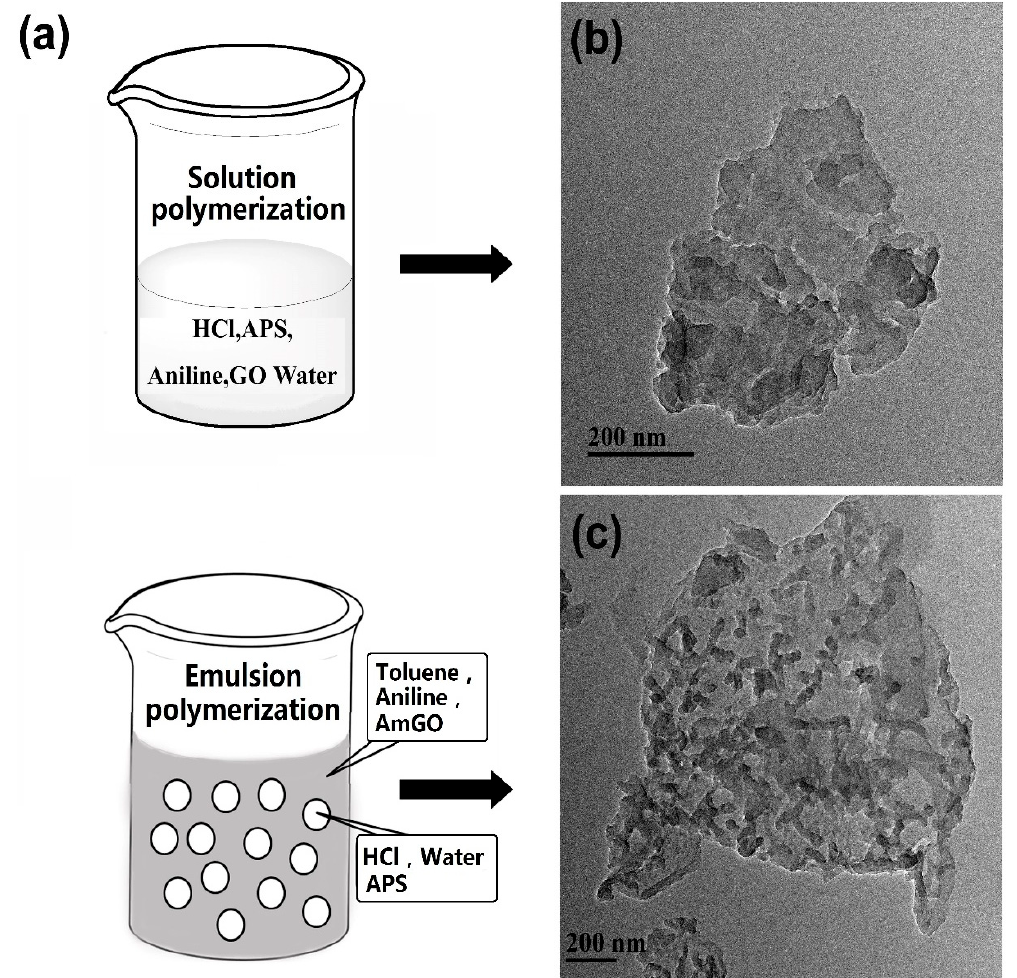
Figure 8. ( a ) Illustration of the solution polymerization and emulsion polymerization process; TEM images of ( b ) GO/PANi and ( c ) AmGO/PANi.